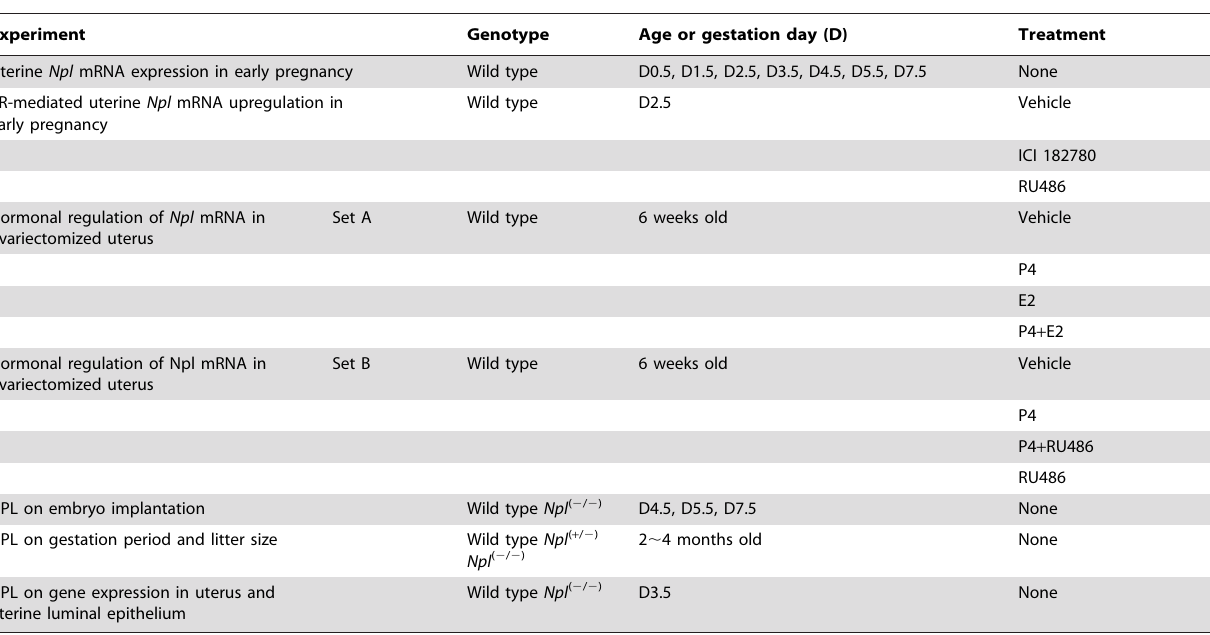
Table 1. Summary of the mouse